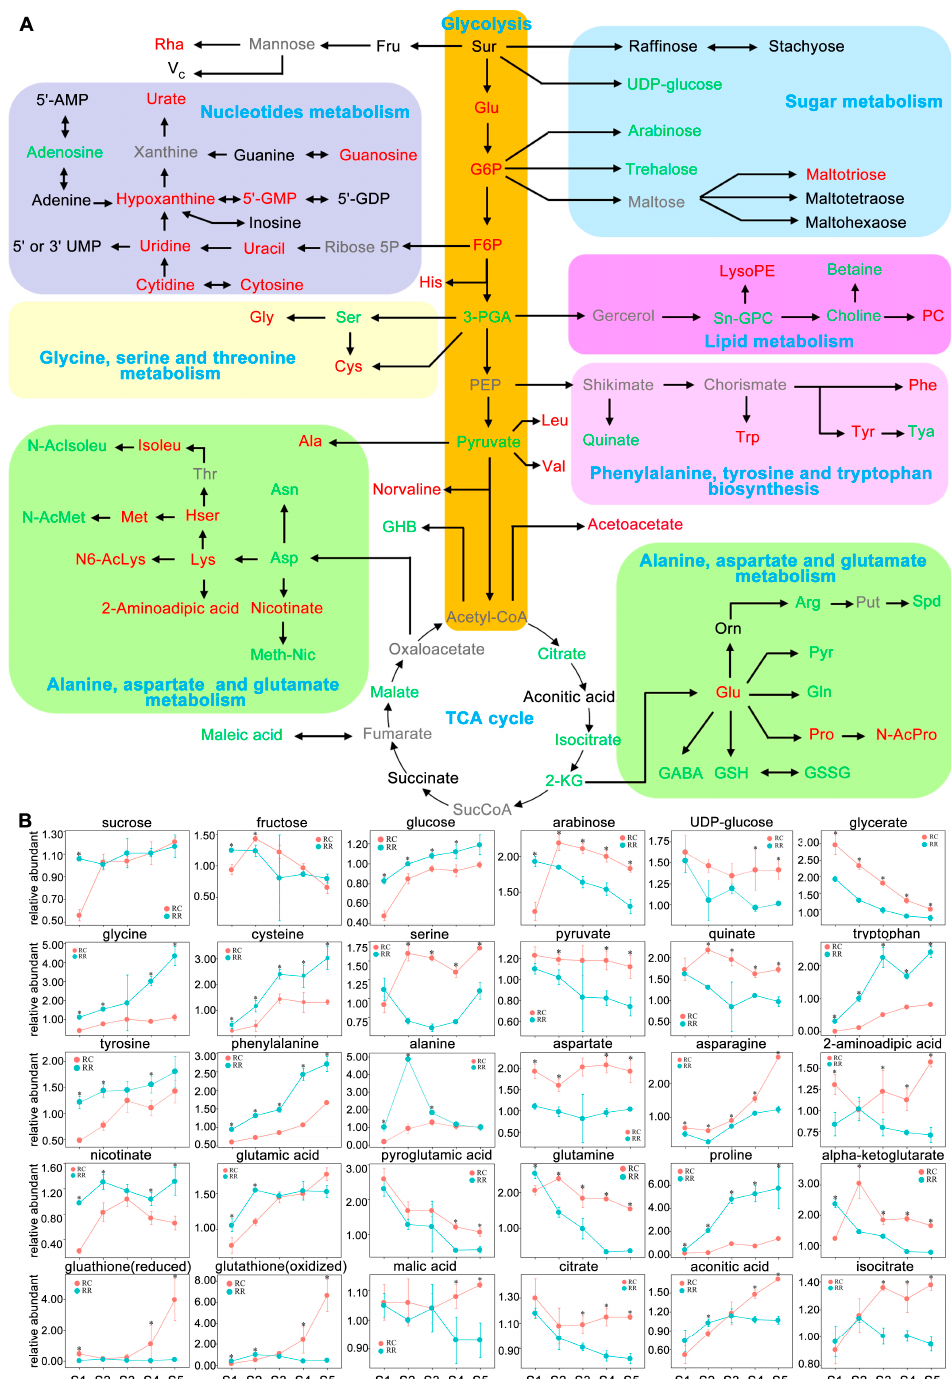
Figure 2. ( A ) Visualization of metabolic dynamics of primary metabolism in skin tissues of developing berries. Representative metabolites with significantly statistical increases and declines more than three stages in RR are written in red and green letters, respectively. Metabolites with black letters indicate their dynamic changes were not significantly different between RR and RC. Metabolites with grey letters represent undetected metabolites. ( B ) Partial of representative metabolites. The relative levels of metabolites were averaged with three biological replicates. Bars represent standard errors. Significant differences were signaled by an asterisk ( p < 0.05) using t -test. Each color of background represents one metabolic